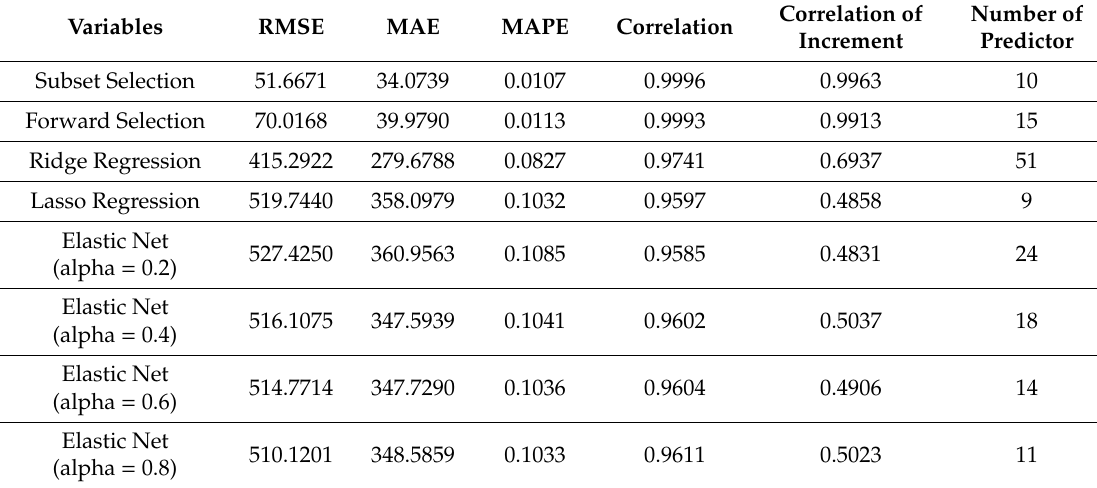
Table 2. Comparison of five methods for the